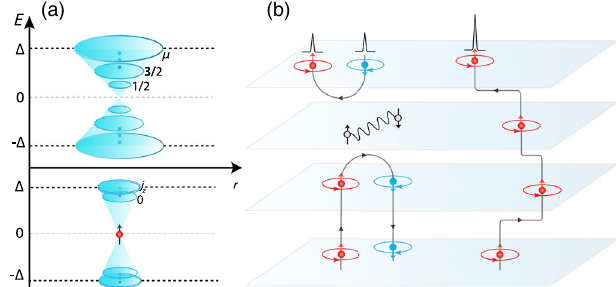
FIG. 1. Schematic rendering of (a) a conventional magnetic- field-induced vortex (top panel) and the QAV nucleated at a magnetic ion (bottom panel), showing energy levels of the in-gap CdGM states localized inside the vortex core and labeled by the quantum numbers μ and j , respectively. Negative energy states z are occupied. (b) Schematic rendering of the quantum anomalous vortex matter in the layered superconductor. Red and blue dots or arrows indicate opposite c -axis moment directions of the mag- netic ions, while arrowed circles represent the vorticities of the QAV. Black lines are the continuous flux lines piercing SC layers through the magnetic ions. Zero-bias peaks indicate the localized MZM from the TSS in the QAV cores where the flux lines enter and leave the sample